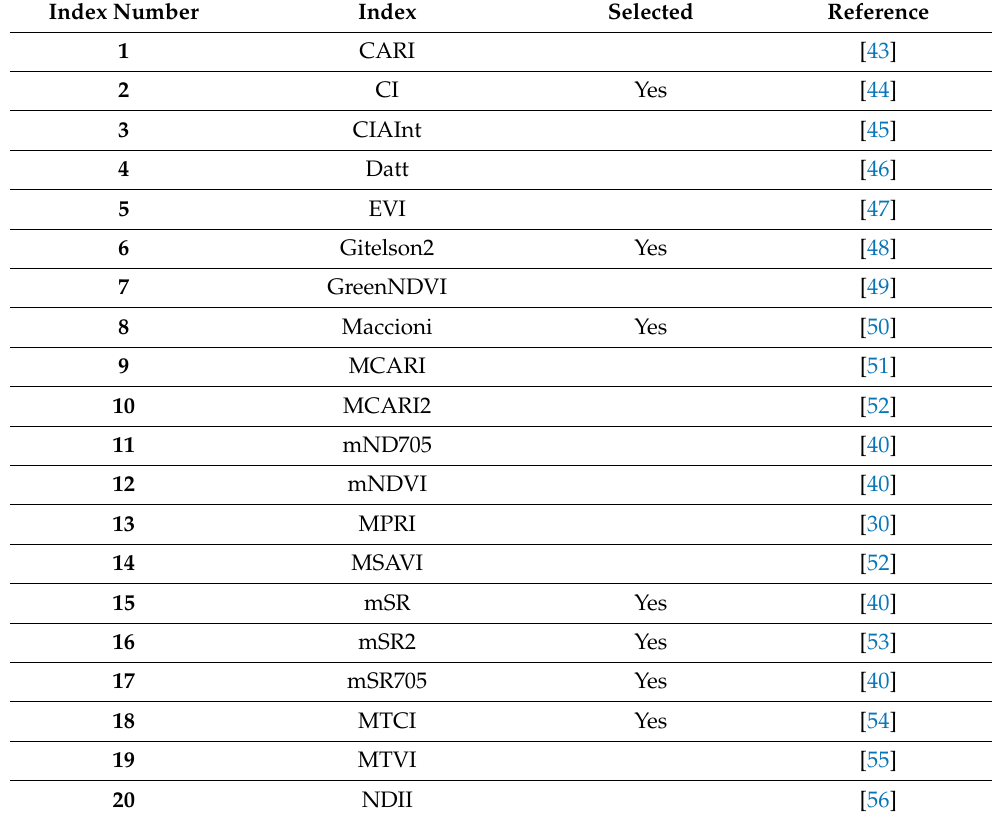
Table 2. List of spectral indices calculated using the Sentinel-2 imagery and employed in the devel- opment of the decline detection model. Selected indices used to build the Random Forest model are